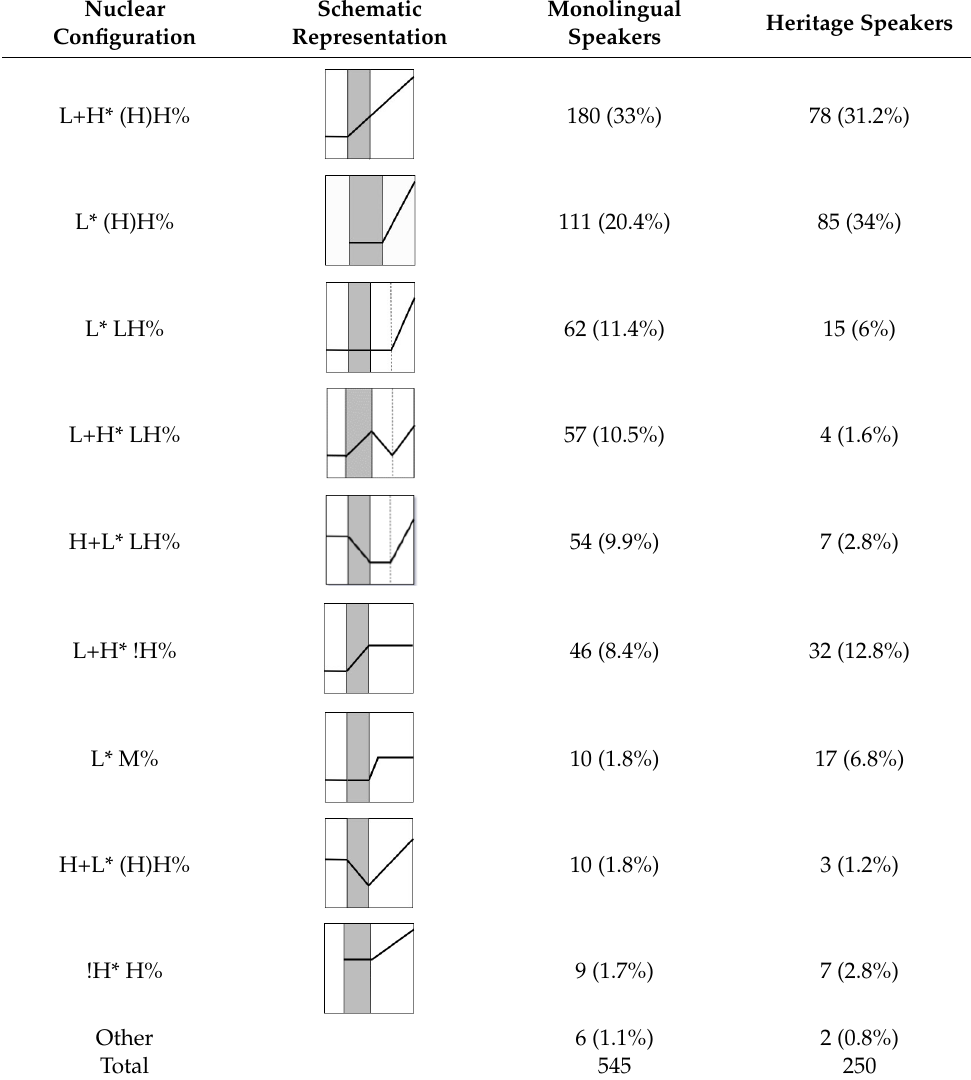
Table 3. Productions of nuclear configurations in uptalks.